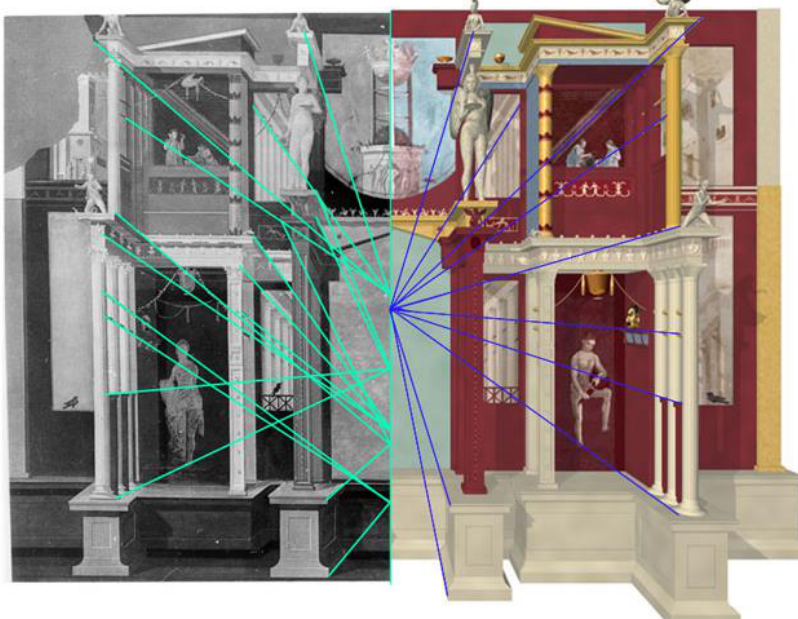
Figure 5. Frigidarium, House of the Cryptoporticus, Pompeii. Source: King’s Visualisation Lab at King’s College London, The Skenographia Project: http://www.kvl.cch.kcl.ac.uk/skeno01.html.